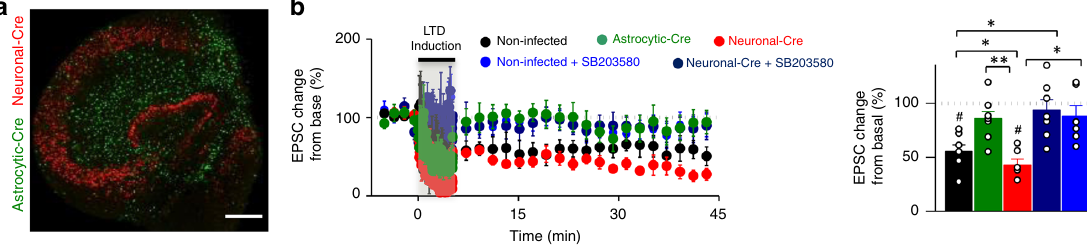
Fig. 7 Astrocytic p38 α MAPK is necessary for NMDAR-dependent LTD. a Representative fl uorescence image of an organotypic hippocampal slice from a p38 α lox/lox mouse simultaneously infected with neuronal AAV5- P CaMKII α -mCherry-Cre (Neuronal-Cre) and astrocytic AAV5- P GFAP -GFP-Cre (Astrocytic- Cre). Scale bar, 200 µ m. b Relative EPSC amplitudes (normalized to baseline values) versus time and average relative changes of EPSC amplitudes 45 min after electrical-LTD induction in control p38 α lox/lox organotypic slices (non-infected; black, n = 7), in the presence of the p38 α /p38 β inhibitor SB203580 (non-infected + SB203580; light blue, n = 7), or in slices infected with astrocytic-Cre (green, n = 8), with neuronal-Cre (red, n = 6), or with neuronal-Cre in the presence of SB203580 (Neuronal-Cre + SB203580; dark blue, n = 6). Differences between groups were determined by Kruskal – Wallis test followed by Dunn ’ s test, (* P < 0.05). Wilcoxon statistical test was used to analyze LTD expression with respect to baseline ( # P < 0.05). Data are presented as means ± s.e.m. For statistical details and n , see